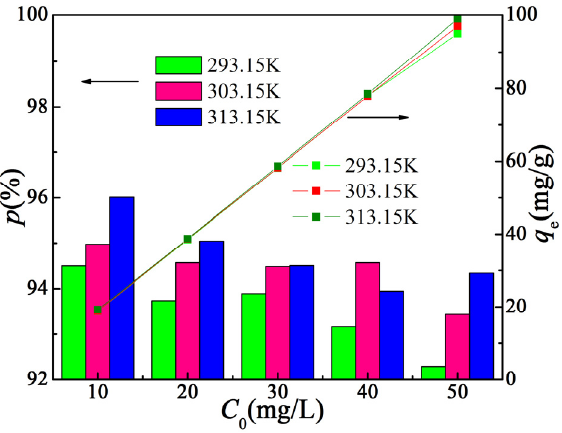
Figure 5. Effect of temperature on the initial concentration dependence for the uptake of MV onto α‐Fe 2 O 3 @PHCMs.